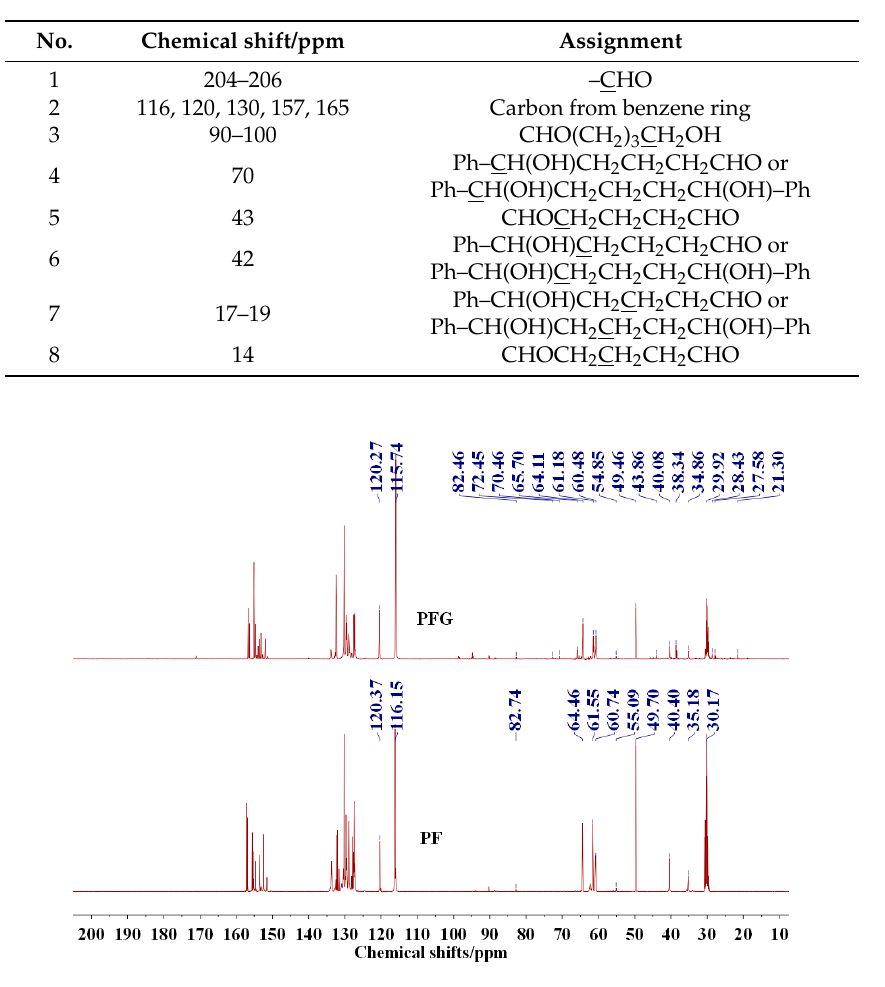
Figure 1. 13 C-NMR spectrum of phenol-glutaraldehyde resin. Table 4. The assignment of 13 C-NMR spectrum of PG resin.